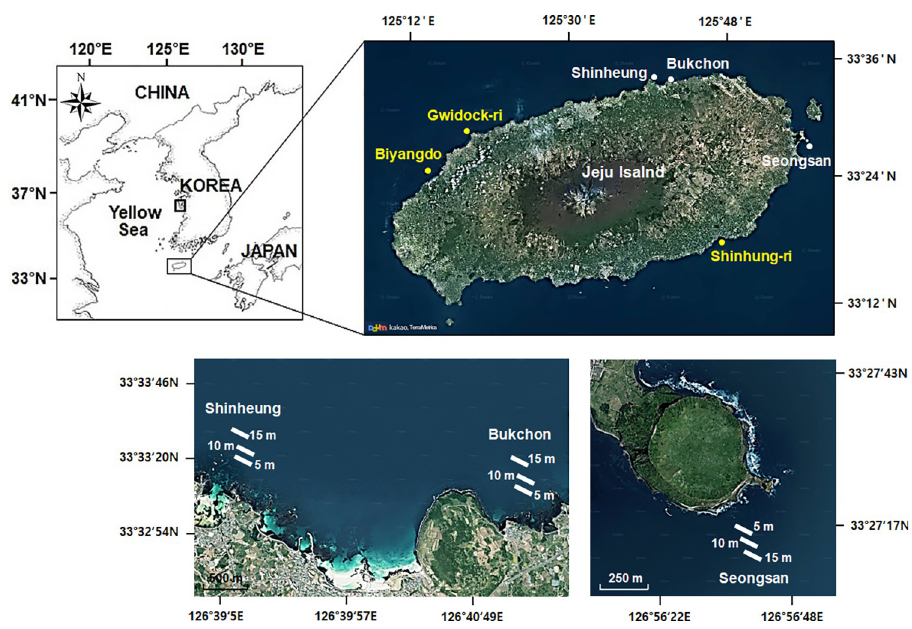
Fig 1. Map showing the sampling locations of 20-m line transects installed at depths of 5 m, 10 m, and 15 m at three survey sites SH, BC, and SS in Jeju Island, Korea. SH = Shinheung, BC = Bukchon, SS = Seongsan, GW = Gwidock-ri, BD = Biyangdo, GN = Geumneung, SH-ri = Shinhung-ri. The locations depicted in white are from this study, and those in yellow are from previously published studies. (Map Source: https://map.kakao.com). https://doi.org/10.1371/journal.pone.0275244.g001 The freehand regions method was used to count the number of A . japonica colonies in the transects (Fig 3, lines in blue). Bleached and dead colonies of A . japonica could be identified from the photo quadrats. Accordingly, we categorized the coral colonies into (1) live colonies with long extended polyps, (2) bleached colonies with white coral tissue, and (3) dead colonies